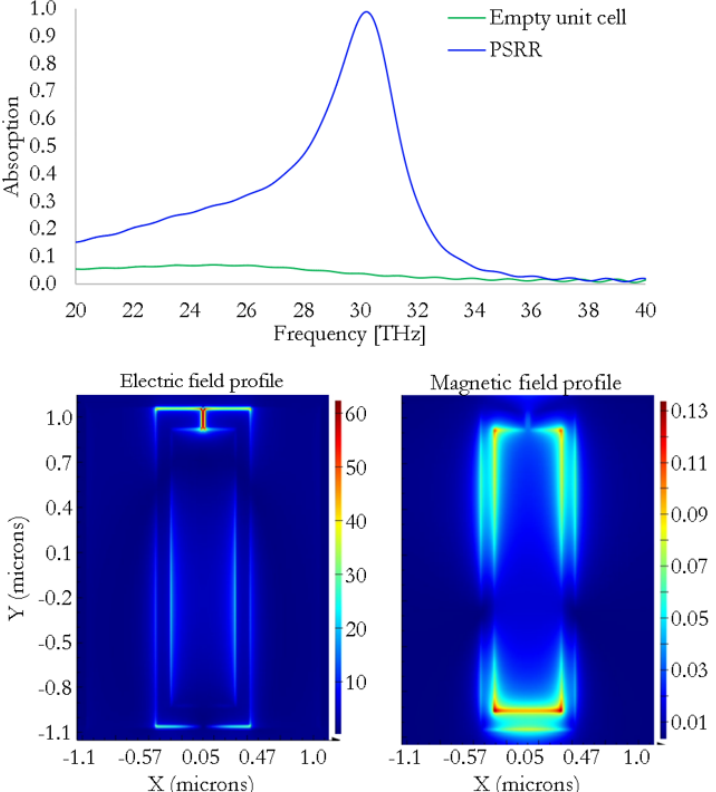
Figure 3. ( top ) Spectral absorption; and ( bottom ) electric and magnetic field profiles in V/m and A/m, respectively, are shown for a unit cell containing a single planar split-ring resonator